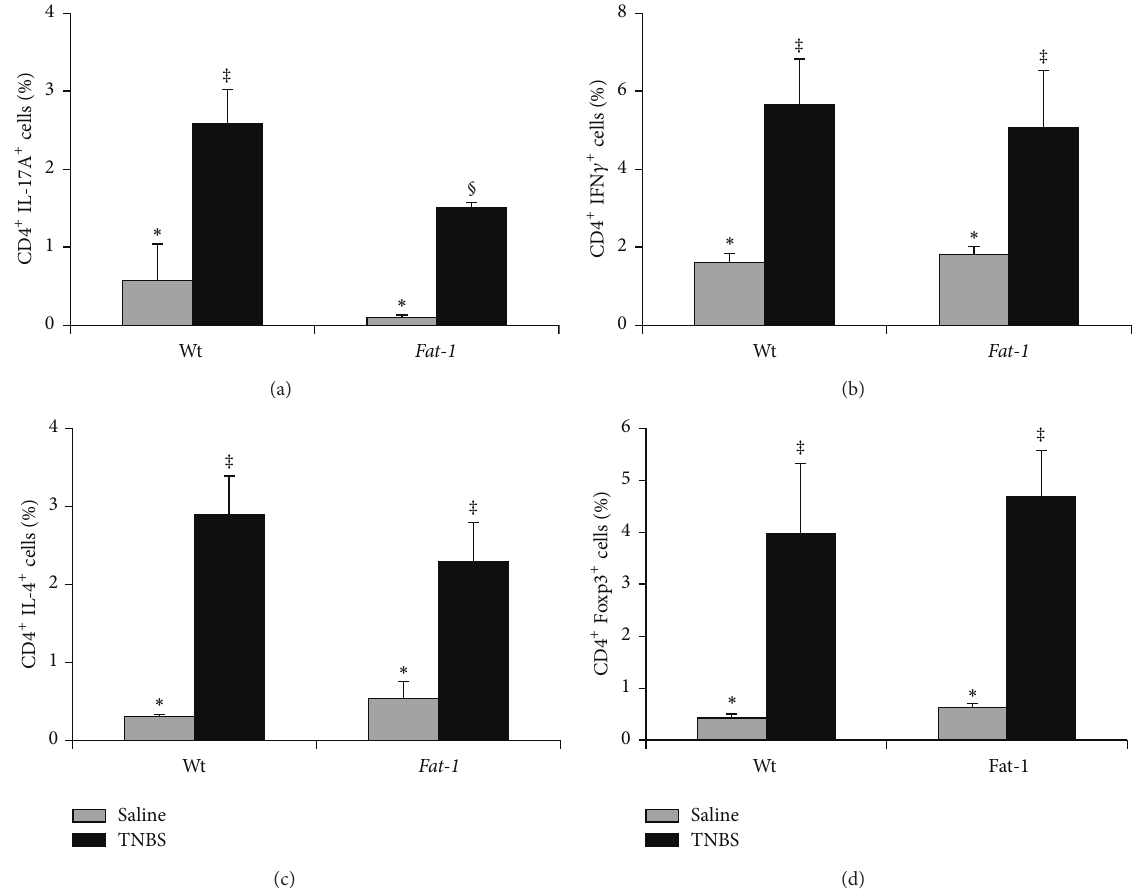
Figure 4: Percentage of splenic CD4 + T cell subsets in Wt and Fat-1 TNBS-treated mice (black bars, 𝑛 = 10 –12 spleens/genotype) and saline controls (grey bars, 𝑛 = 4 /genotype). (a) Th17 cells (CD4 + IL-17A + ), (b) Th1 cells (CD4 + IFN 𝛾 + ), (c) Th2 cells (CD4 + IL-4 + ), and (d) Tregs (CD4 + Foxp3 + ). Data were analyzed by two-way ANOVA (main effects: genotype and treatment). Bars represent means ± SEM. Bars not sharing a symbol differ ( 𝑃 ≤ 0.05